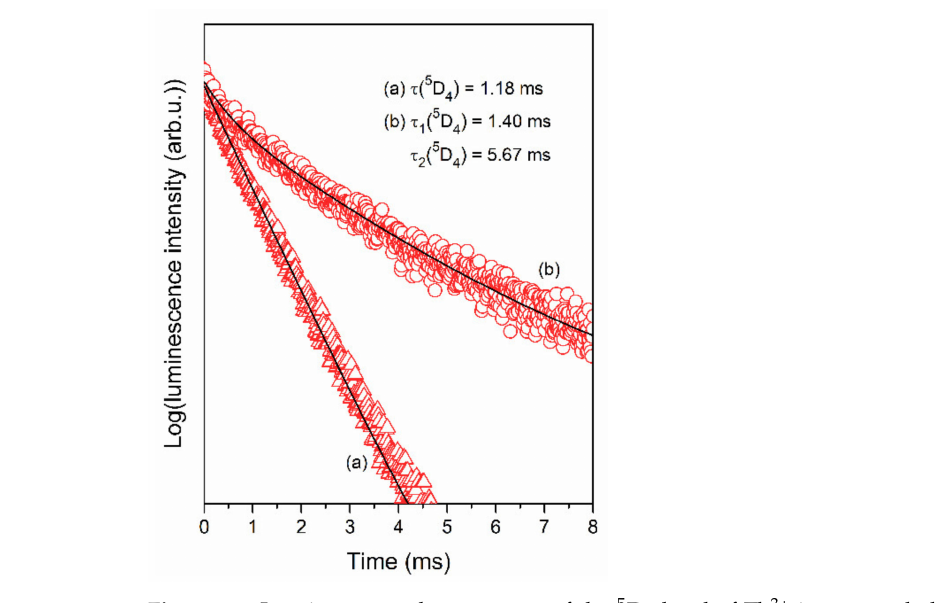
Figure 11. Luminescence decay curves of the 5 D 4 level of Tb 3+ ions recorded for ( a ) XG 1Tb , and